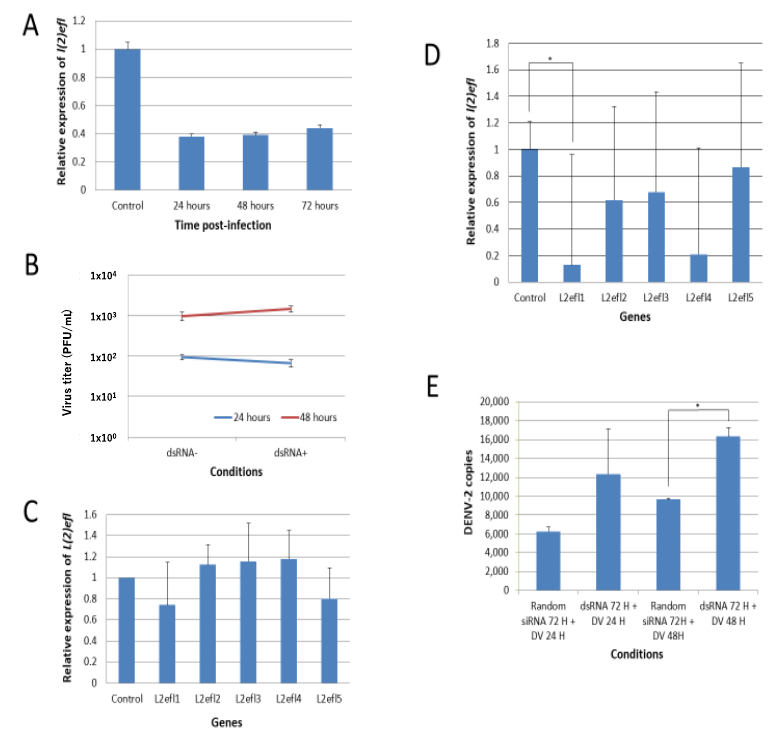
Figure 3. Suppression of l(2)efl-1 and l(2)efl-4 promotes dengue virus type 2 replication in CCL-125 cells. ( A ) Gene-specific dsRNAs ablated 60% of l(2)efl transcripts for as long as 72 h post transfection. ( B ) Suppression did not cause any difference in the dengue virus type 2 (DENV2) replication 24 and 48 h post infection, which may have been due to compensation by other l(2)efl homologs ( C ). ( D ) RNAi effectively repressed l(2)efl-1 and l(2)efl-4 transcripts, but only partially affected l(2)efl-2 and l(2)efl-3 . ( E ) l(2)efl-1 and l(2)efl-4 transcript ablation enhanced the DENV2 replication by as much as 2-